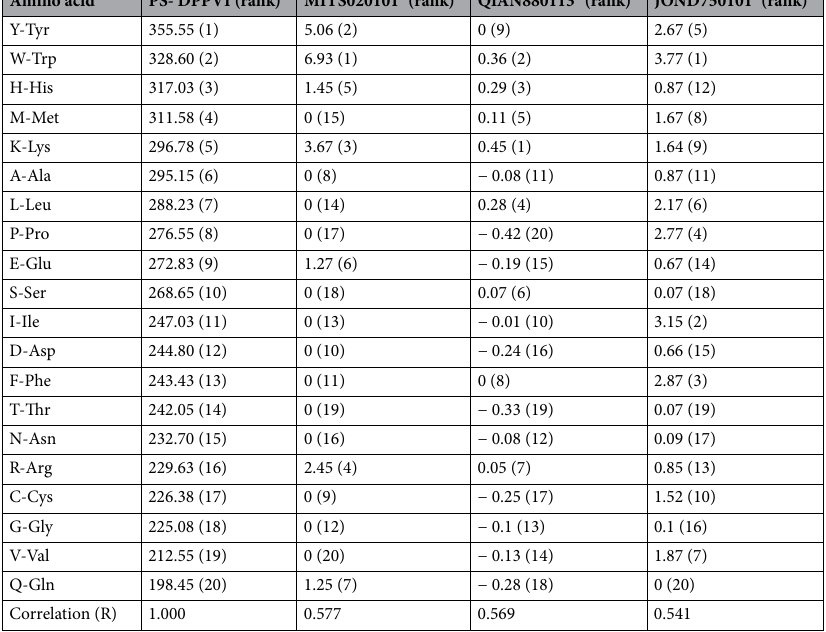
Table 6. Important physicochemical properties (PCPs) as derived from the iACP-FSCM. a MITS020101 = Amphiphilicity index (Mitaku et al., 2002). b QIAN880113 = Weights for alpha-helix at